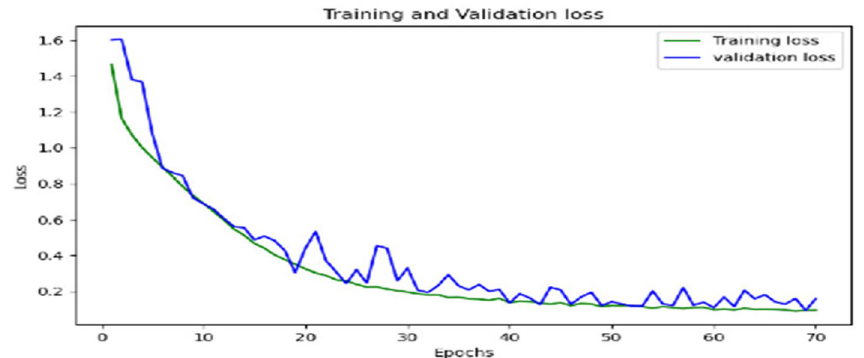
Fig. 5 The loss of training and validation